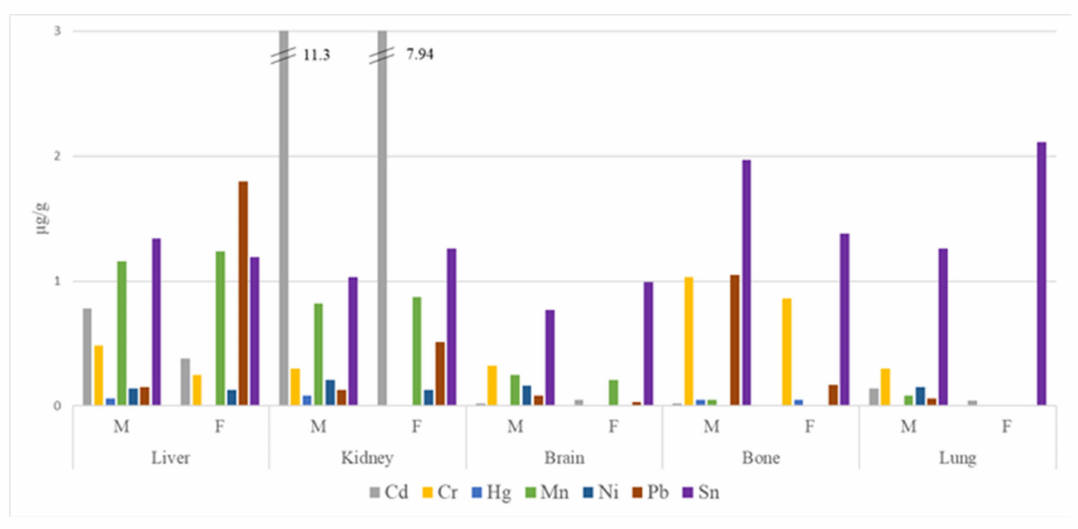
Figure 1. Concentrations (in µ g / g) of trace elements in samples of autopsy tissues collected in 2019 according to the sex of the subjects (M: male; F: